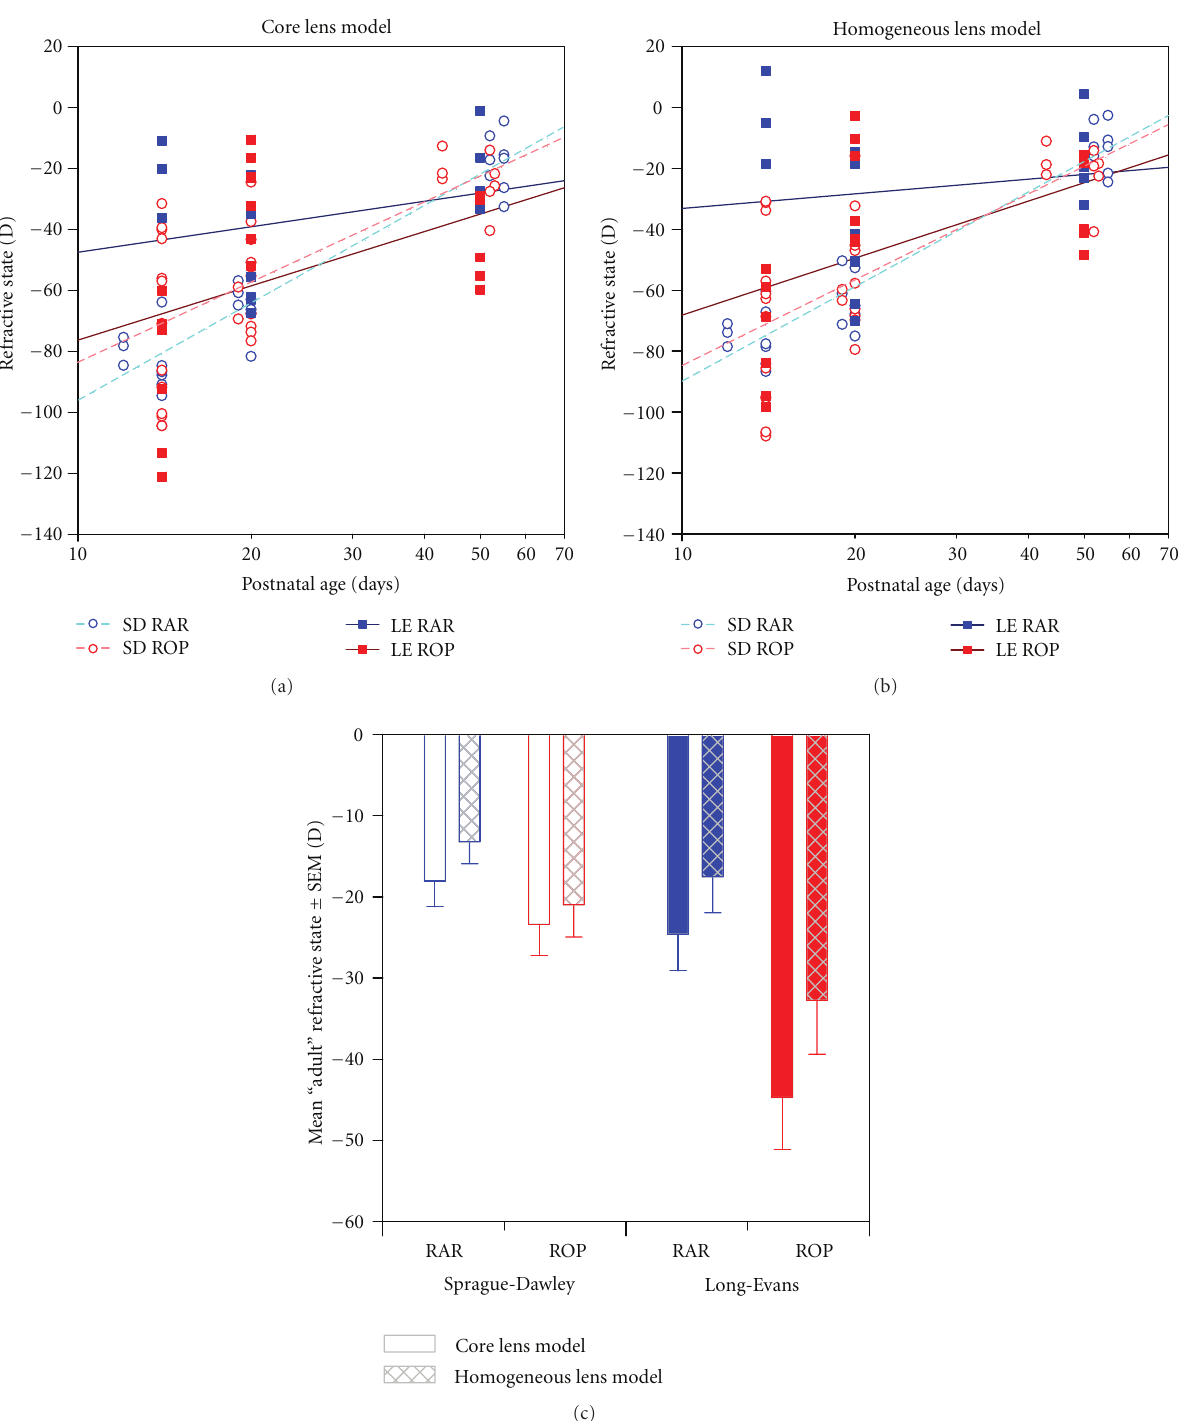
Figure 4: Measurements of refractive state, R (cid:2) . (a) R (cid:2) measured using the core lens model (R (cid:2) core ). Lines are log-linear regressions through Sprague-Dawley ( light dashed ) and Long-Evans ( dark solid ) ROP ( red ) and RAR ( blue ) rats’ data. (b) R (cid:2) measured using the homogeneous lens model (R (cid:2) hmgns ). Lines as in (a). (c) R (cid:2) at ∼ P50, an “adult”